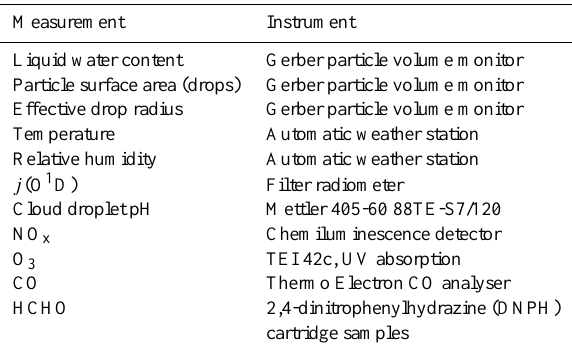
Table 1. Details of ancillary measurements used for comparison with radical observations and cubic model